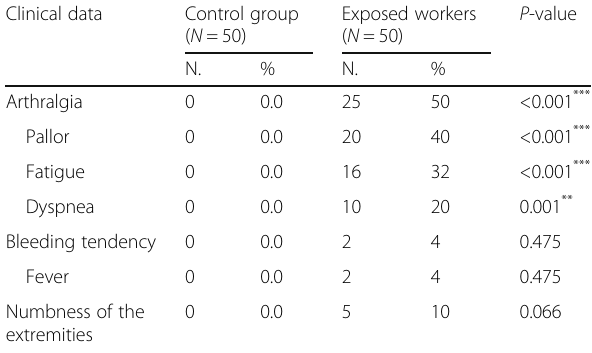
Table 2 Clinical data of the general examination of exposed workers compared to